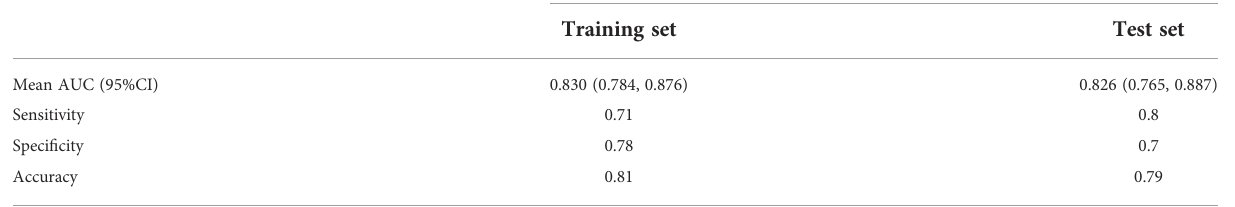
TABLE 4 Predictive performance for the HBP model.